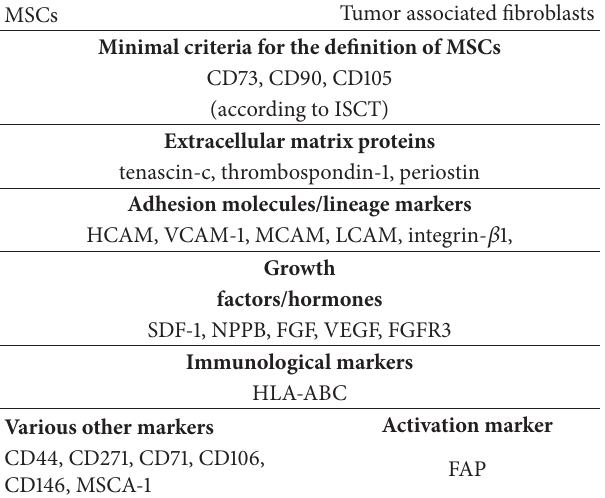
Table 2: (Positive) Phenotypic markers and features for both MSCs and TAFs based on [15, 60–63]. Markers for which presence in both TAFs and MSCs has been demonstrated are shown in the middle while markers which have only been demonstrated in either one of the cell types are presented in the left or right column.